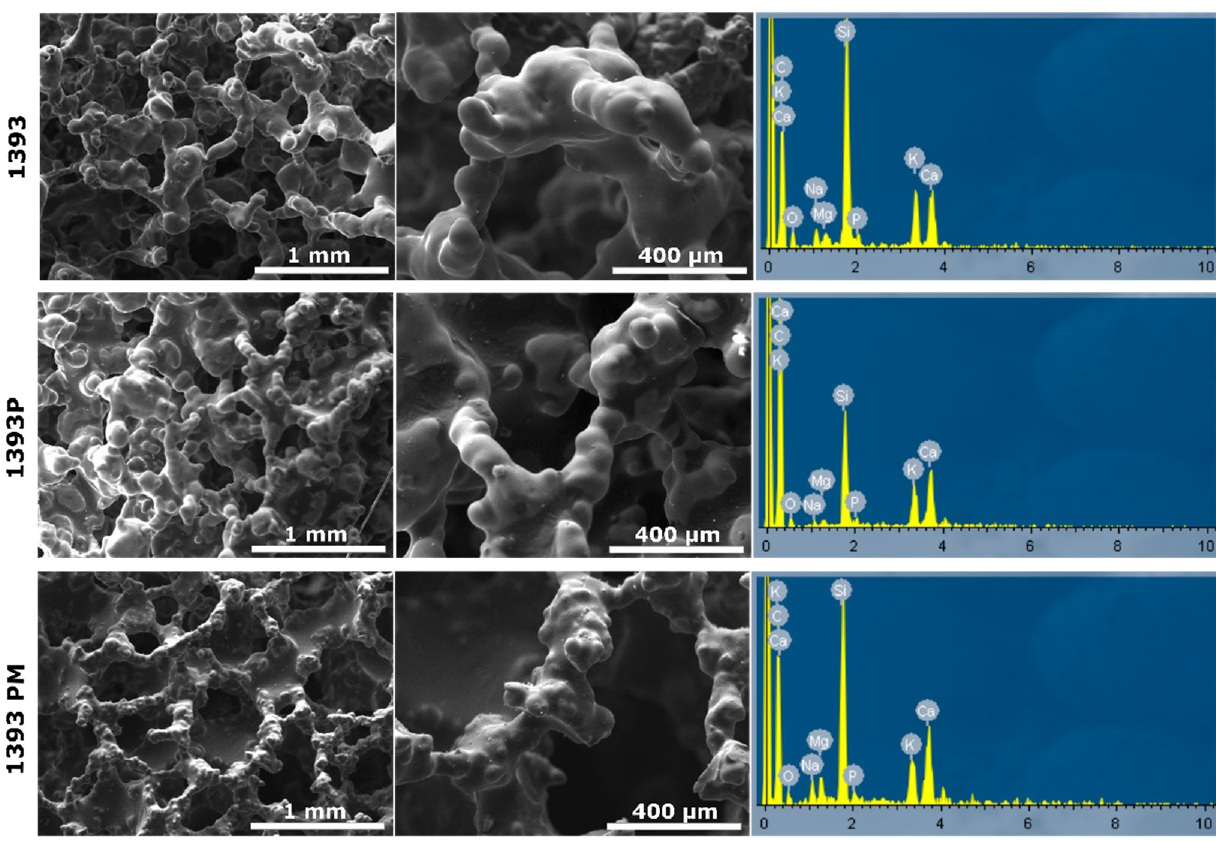
Figure 4. SEM micrographs and EDS spectra of 1393 bioactive glass (1393), PGSuc-coated 1393 bio- active glass (1393P) and MSNs with DexSP-loaded and PGSuc-coated 1393 bioactive glass scaffolds (1393PM corresponding to 1393PM 15%).